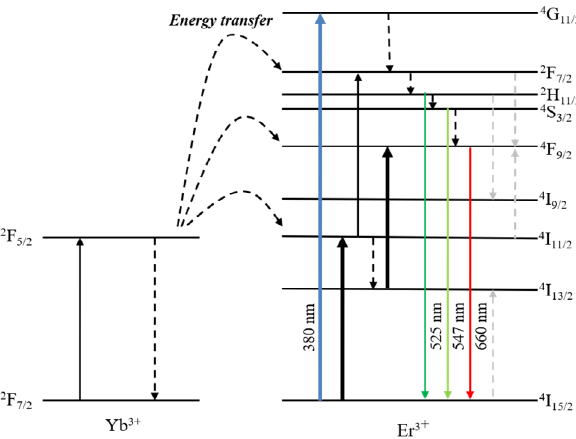
Fig. 9 Energy-level schemes of Er 3+ and Yb 3+ and optical transitions: photoexcitations (upward arrows), radiative relaxations (downward solid arrows), non- radiative relaxations (downward dotted arrows), cross relaxations (gray dotted line), and energy transfers from Yb 3+ to Er 3+ (curved